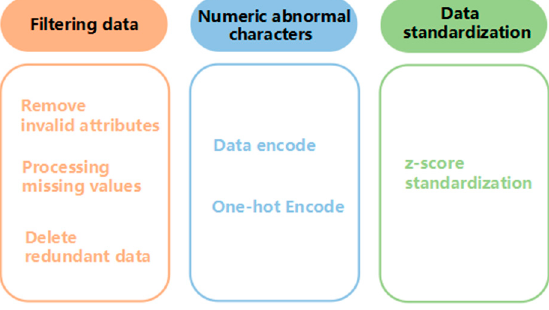
Figure 3. Abnormal flow data preprocessing method.